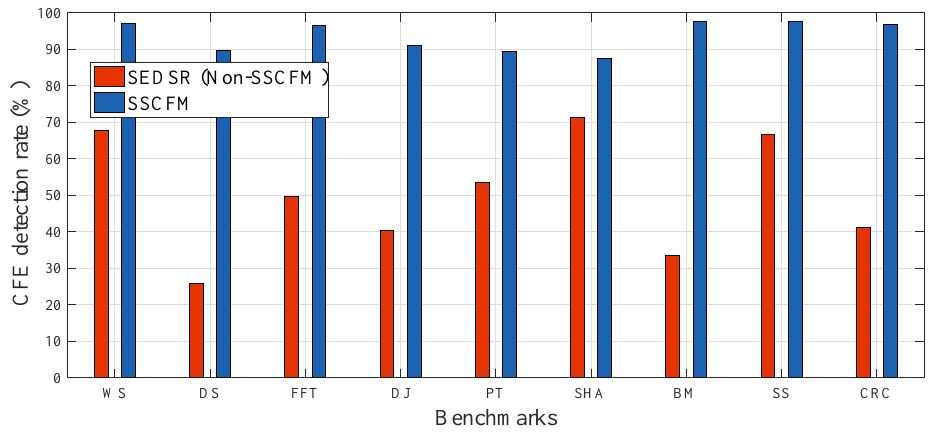
Figure 11. CFE detection